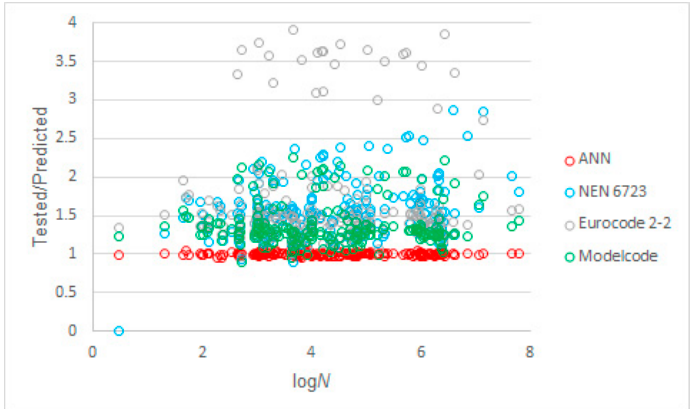
Figure 9. Tested to predicted values for all considered methods as a function of the number of cycles to failure, N .